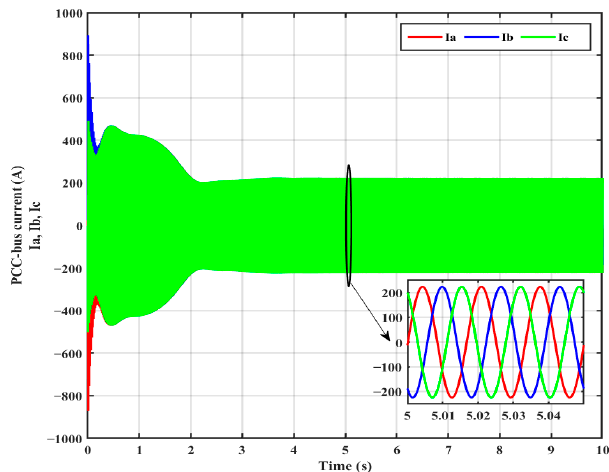
Figure 20. Current of PCC bus.